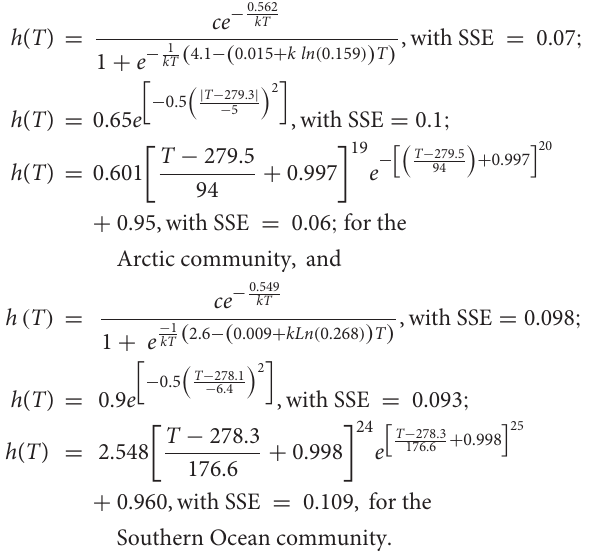
Frontiers in Marine Science |